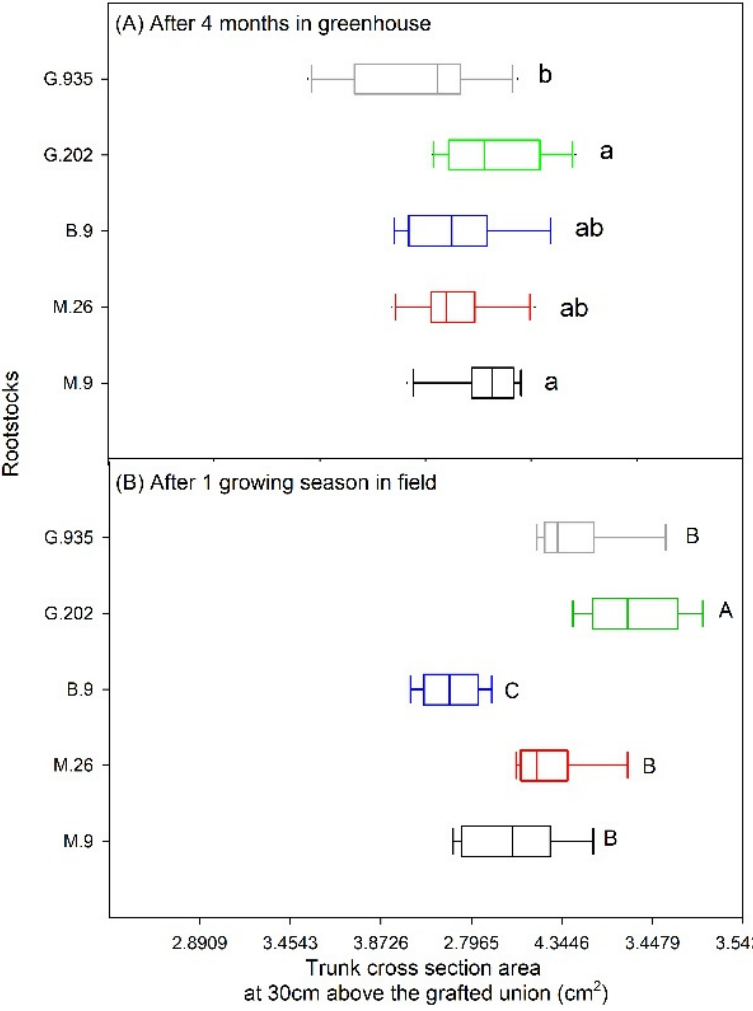
Figure 5. Trunk cross-sectional area of Ambrosia TM scion on five rootstocks after four months in the greenhouse ( A ), and after a growing season in the field ( B ). Different letters in each sub-panel stand for significant differences amongst rootstocks ( P ≤ 0.05, ANOVA, Fisher LSD pairwise comparisons; ( A ): n = 10; ( B ): n = 6, each replication consists of 3 trees).